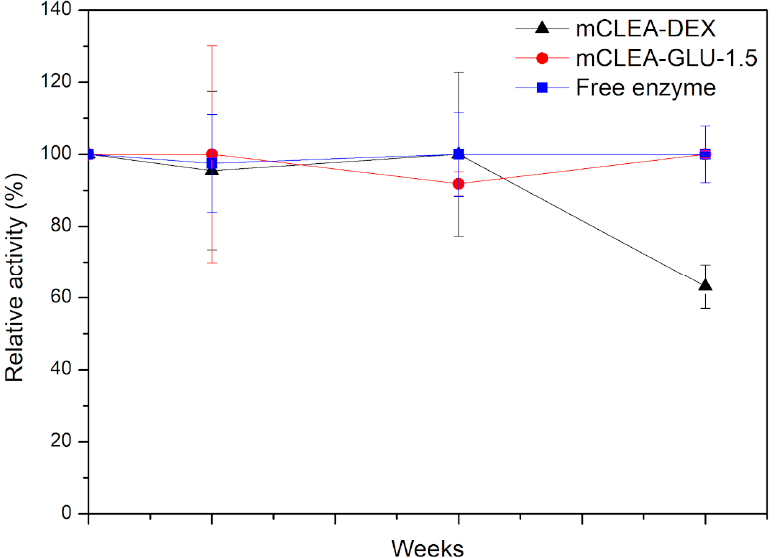
Figure 5. Storage stability of β -galactosidase from Aspergillus oryzae biocatalysts: mCLEA-GLU-1.5, mCLEA-DEX and Free enzyme. Analysis conditions: 0.1 g of heterogeneous biocatalyst in 1 mL of potassium phosphate buffer (pH 6.6), with 0.1 mM MnCl 2 as a cofactor, at 37 °C. The activity was obtained by reading the absorbance at 420 nm, for 2 min, by reacting 50 µL of the suspension in 2 mL of 1.25 mM ONPG.